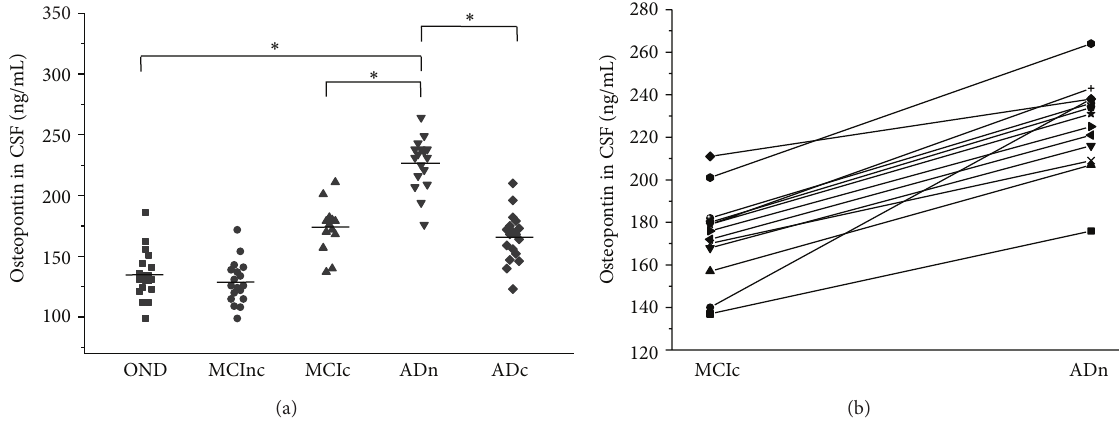
Figure 2: Osteopontin protein levels in the cerebrospinal fluid (CSF) of each group patients. The horizontal lines represent the mean values of each group, and asterisks show statistical significance ( ∗ 𝑃 < 0.01 ). (a) Osteopontin concentrations in CSF of 20 other noninflammatory neurologicdiseases(OND),18clinicallystablemildcognitiveimpairmentpatients(MCInc),13mildcognitiveimpairmentconverters(MCIc), 17 newly diagnosed AD (ADn), and 18 chronical AD patients (ADc) were determined using an enzyme-linked immunosorbent assay (ELISA). (b) The CSF osteopontin concentrations within the same individual ( 𝑛 = 13 ) at different disease